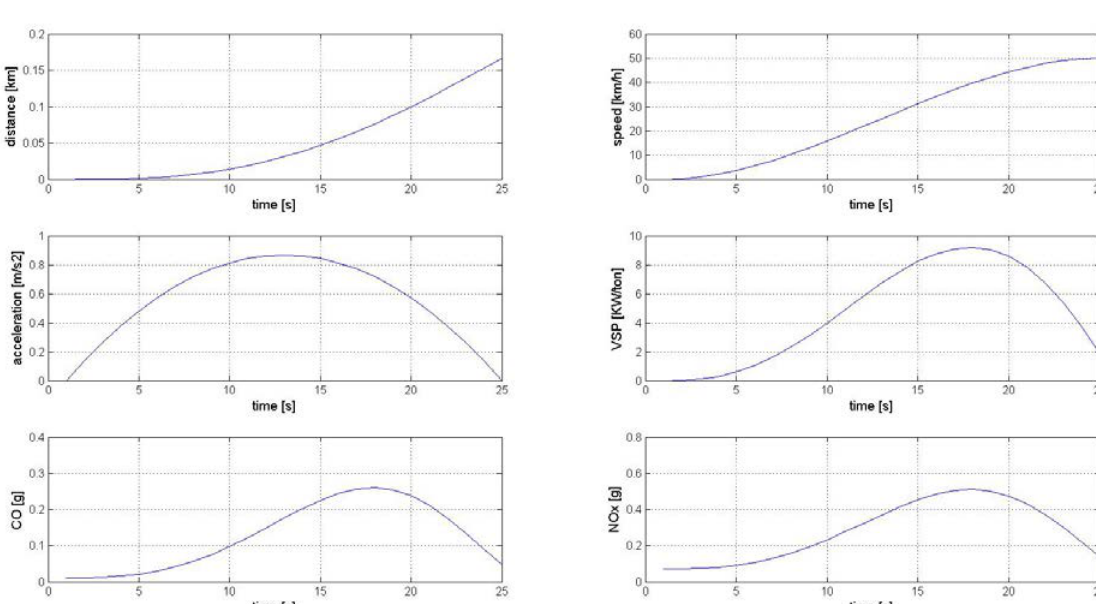
Figure 2. Kinematic parameters light vehicles (Link type 50km/h).